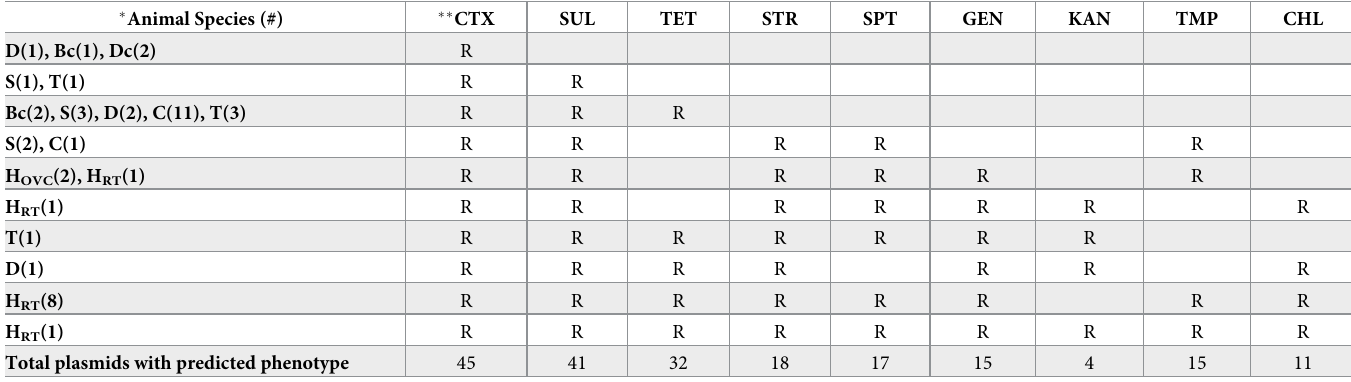
Table 3. The number of plasmids from each animal species with the corresponding predicted resistance phenotype. � Animal Species (#) �� CTX SUL TET STR SPT GEN KAN TMP